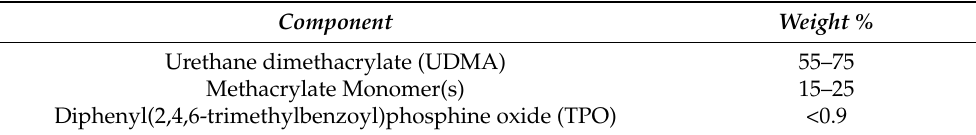
Table 1. Formlabs Clear V4 resin composition according to supplier data sheet.